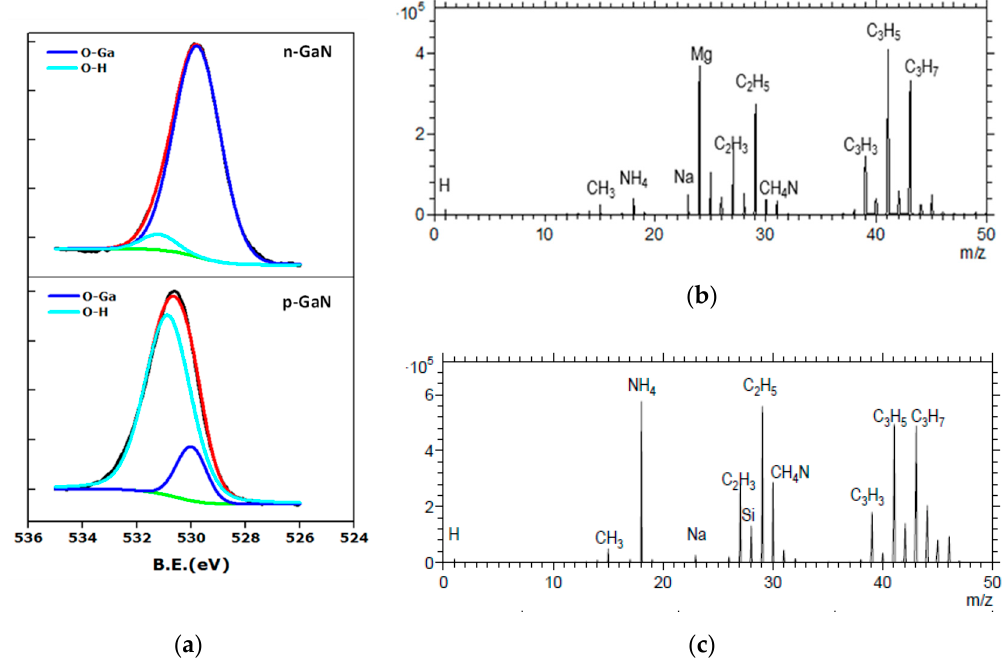
Figure 3. ( a ) O1s XP spectra of hydroxylated n-GaN (top) and p-GaN (bottom) surfaces. Background (green), fitted curve (red), experimental curve (black) and deconvoluted curves corresponding to O ‒ Ga (dark blue) and O ‒ H (light blue) bonds, x-axis: Binding energy (eV), y-axis: Intensity (a.u.). Time-of-flight secondary ion mass spectrometry (ToF-SIMS) spectrum of blank ( b ) p-GaN ( A ) and ( c ) n-GaN ( B ) surfaces, x-axis: Mass/charge ratio (m/z), y-axis: Intensity (a.u.).